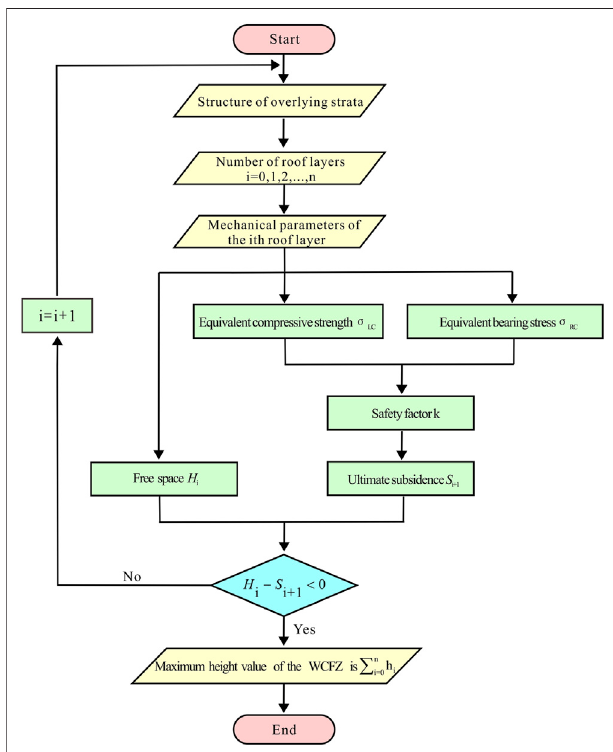
FIGURE 5 | Calculation fl ow-process diagram of the maximum height of the